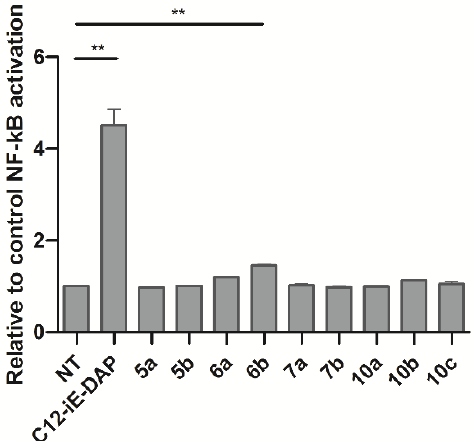
Figure 3. Effects of conformationally constrained lipophilic analogs of γ - d -glutamyl- meso -diaminopimelic acid 5a – b , 6a – b , 7a – b , and 10a – c on the NF- κ B transcriptional activity. Secreted embryonic alkaline phosphatase (SEAP) activity was measured in HEK-Blue NOD1 cells after incubation for 20 h with C12-iE-DAP (100 nM) and synthesized compounds (10 µ M). Columns represent means of duplicates of two independent experiments. Error bars indicate ± S.E.M.; ** p < 0.01 vs. untreated cells (ctrl).